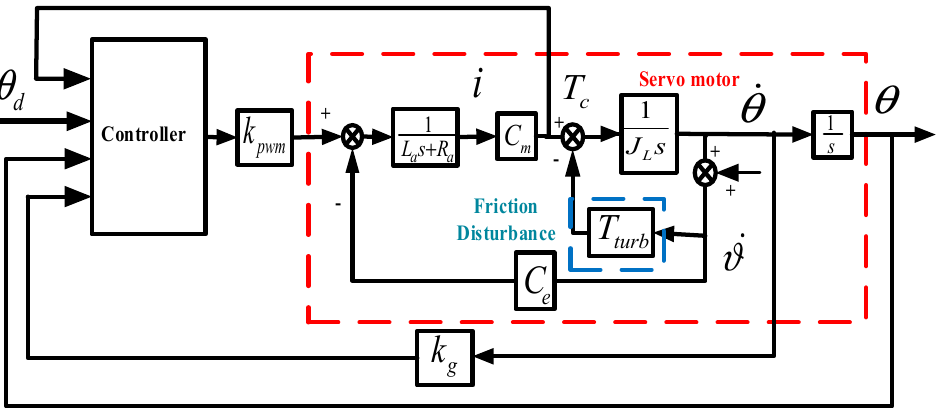
Figure 3. Block diagram of the RSSSP tracking loop.